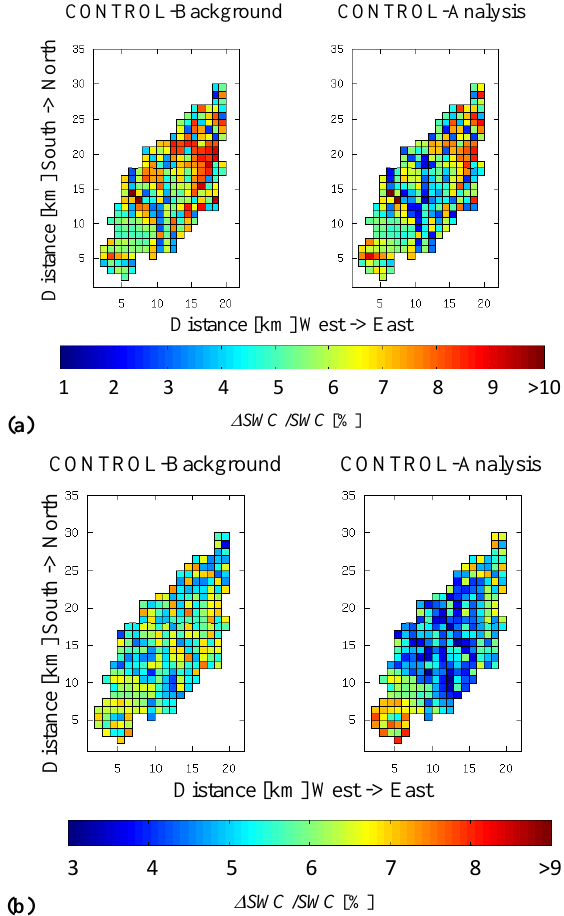
Fig. 10. As Fig. 9, but (a) for the top 3 soil layers of TERRA- ML, i.e. 0–0.09m depth of the soil, and (b) for the 4th soil layer of TERRA-ML, i.e. 0.09–0.27m depth of the